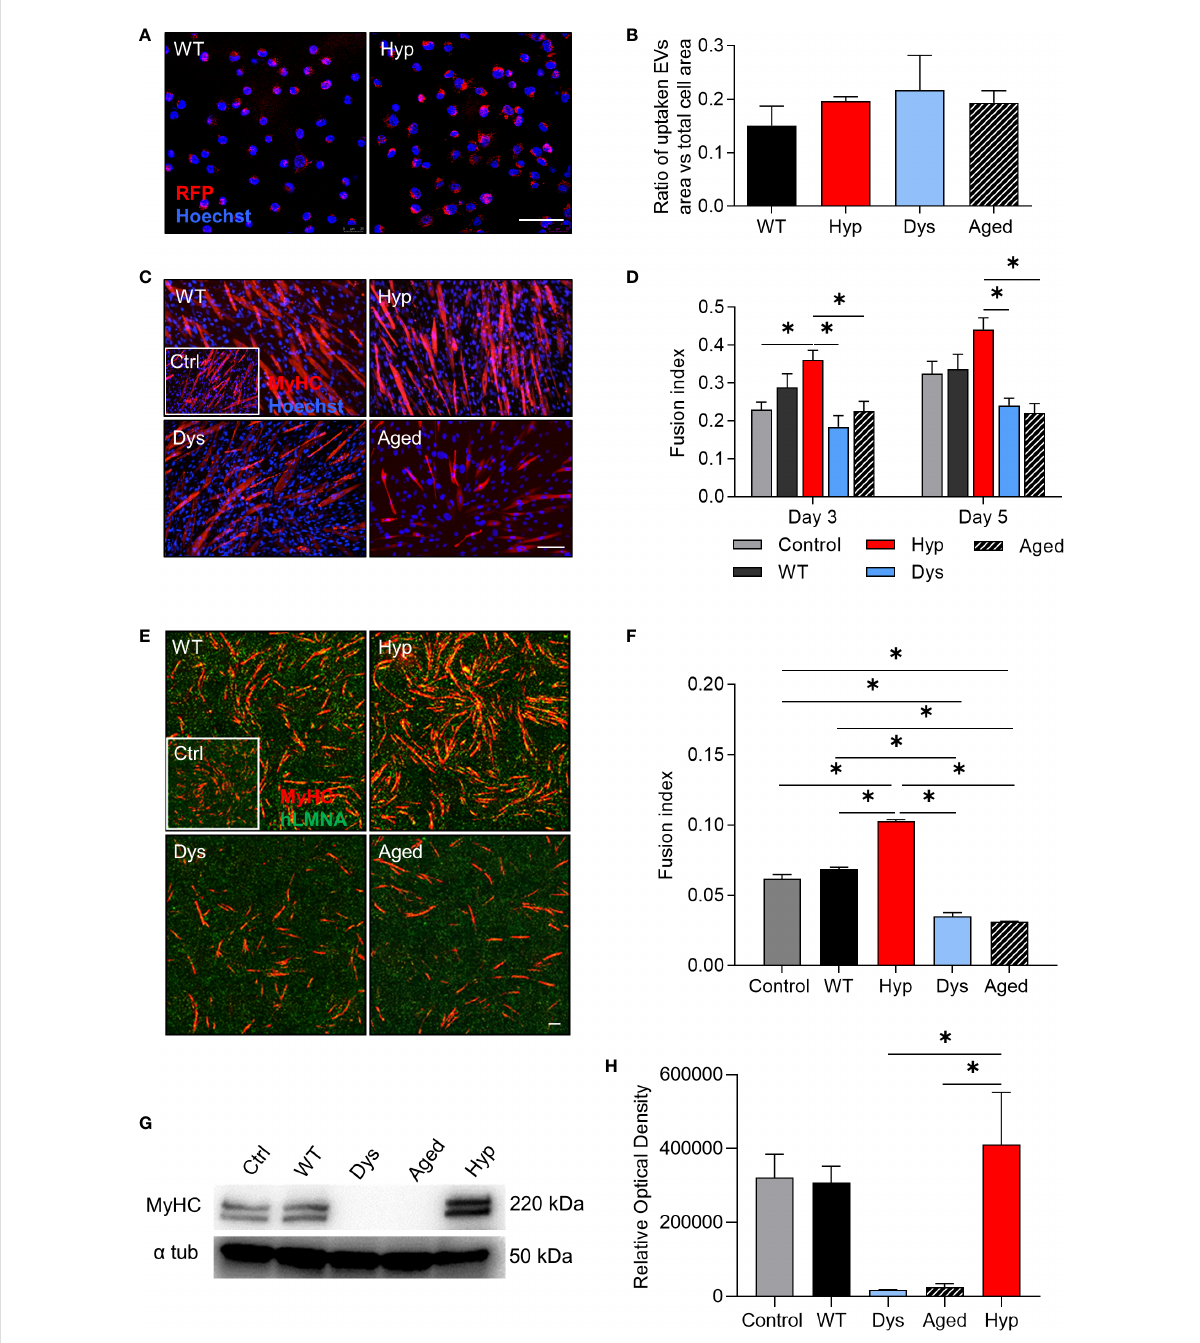
FIGURE 2 Effect of extracellular vesicle treatment on myogenic differentiation of progenitor cells. (A) Red fl uorescent protein-marked extracellular vesicle (EV) uptake (red) from mouse myoblast cell line C2C12 after 4 hours of EV treatment. Representative confocal images of cells treated with wild type (WT)- and hypertrophic (Hyp)-derived EV samples are shown. Hoechst was counterstained in blue. (B) Quanti fi cation of EV uptake in C2C12 myoblasts after 4 hours of EV treatment (n=4 per group). (C) Myogenic differentiation of C2C12 cells incubated with WT-, Hyp-, dystrophic (Dys)-, and aged-derived EVs. Immuno fl uorescence analysis for myosin heavy chain (MyHC) (red). Hoechst was counterstained in blue. (D) Fusion index of differentiated C2C12 cells at days 3 and 5 of myogenic differentiation (n = 5). (E) Myogenic differentiation of human mesoangioblasts (hMABs) treated with EVs. Immuno fl uorescence analysis for MyHC (red) and human lamin A/C (green). (F) Fusion index of differentiated hMABs at day 12 (n = 3). (G) Example of a western blot for MyHC protein level at day 12 of myogenic differentiation. GAPDH was used as a loading control. (H) Quanti fi cation of MyHC western blot. For a, c, and e, scale bars: 50 µm. For b, d, f, and h one-way ANOVA was used and results are displayed as mean±s.e.m (n=3-5, *p <